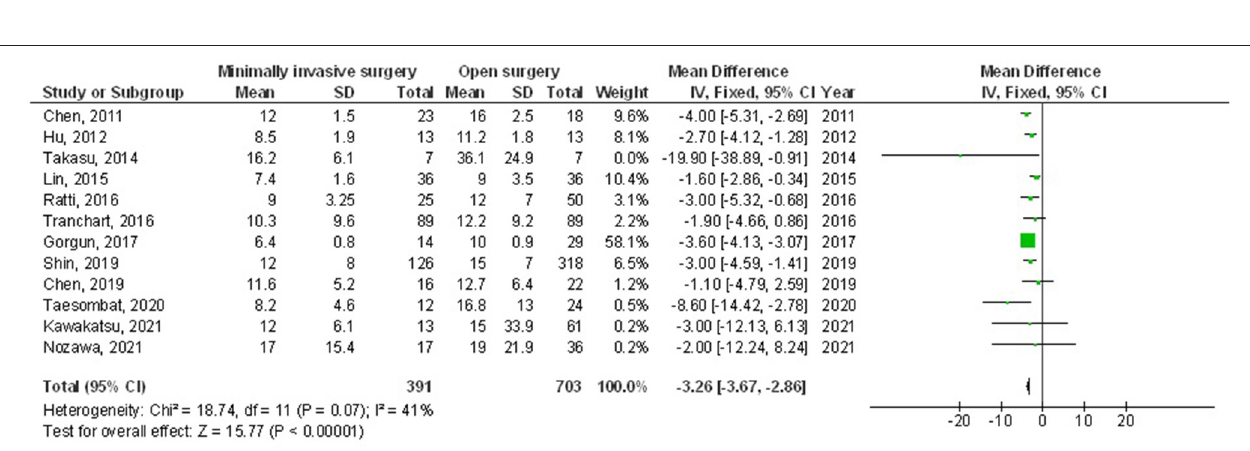
FIGURE 4 | Forest plot of the effect of minimally invasive surgery compared to open surgery on blood transfusion needs in subjects with colorectal cancer and synchronous colorectal liver metastases.